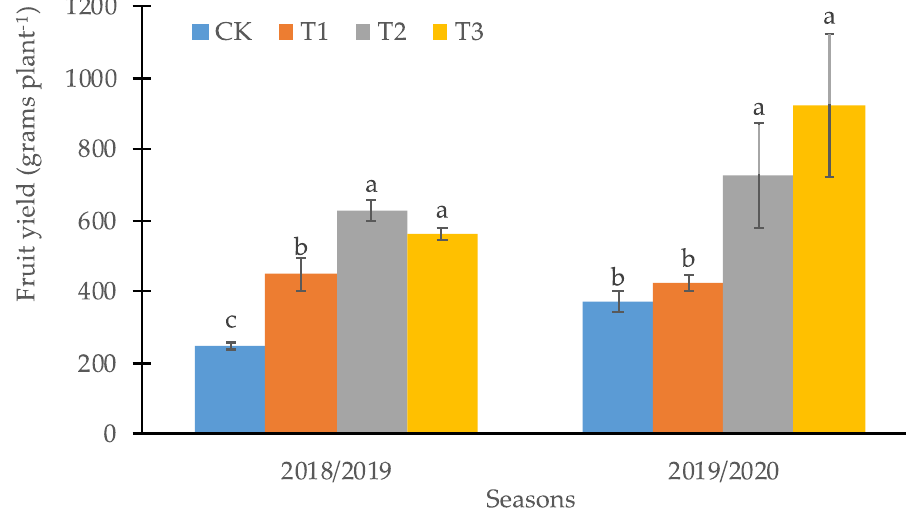
Figure 8. Effect of different doses of compost on the yield of calafate fruit ( Berberis microphylla G. Forst) for the 2018–2019 and 2019–2020 seasons. CK = Control treatment (without application of com-post); T1 = Treatment 1 (5 Ton ha − 1 ); T2 = Treatment 2 (10 Ton ha − 1 ); T3 = Treatment 3 (15 Ton ha − 1 ). For each season, different lowercase letters indicate significant differences in the different treatments according to Fischer’s LSD test ( p < 0.05). The bars correspond to the experimental error of each treatment.